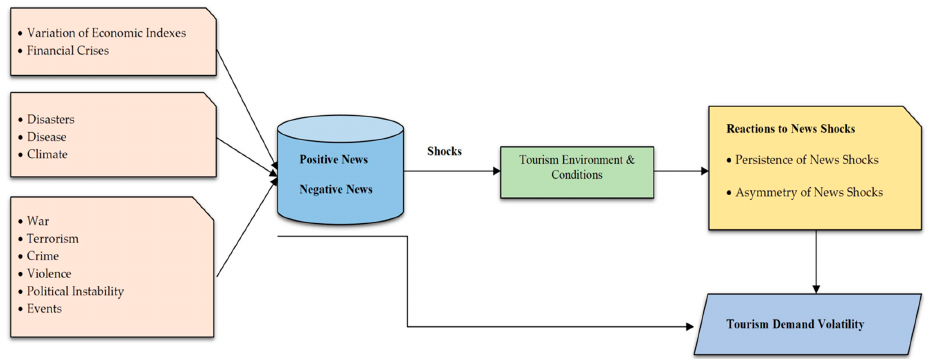
Figure 1. Effects of news shocks on tourism demand volatility (Source: from Kim and Wong (2006)).